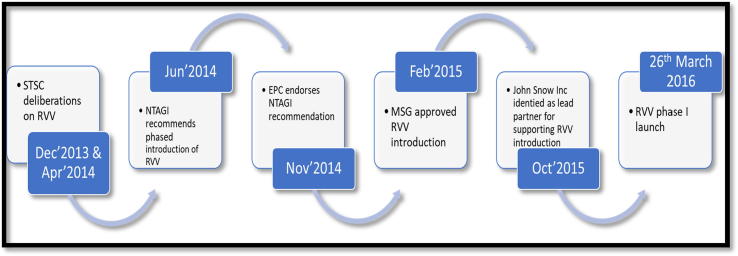
Decision making process for RVV introduction in India.